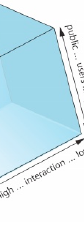
Figure 1. MacEachren's (2004) geovisualisation cube with key dimensions relating to human and map interaction (MacEachren et al.,